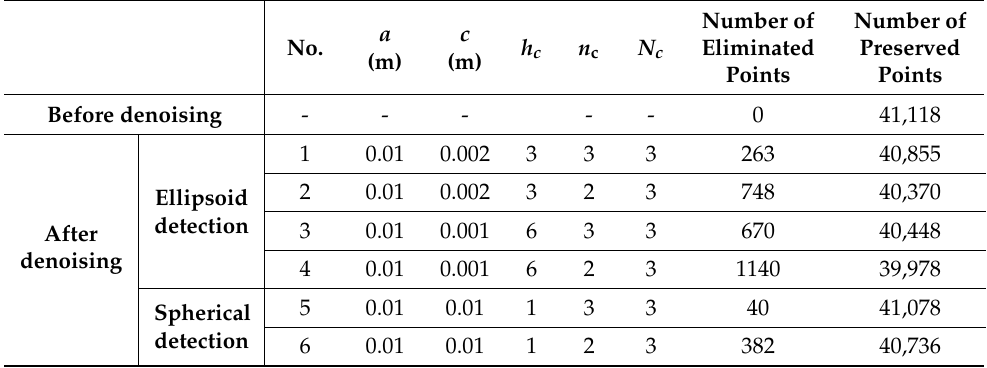
Table 3. The denoising results of the concrete pavement point cloud without foreign body noise points by different denoising parameters.